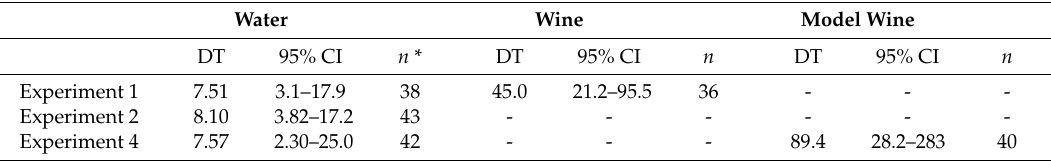
Table 2. Detection Thresholds ( µ g/L) for Methyl Anthranilate.